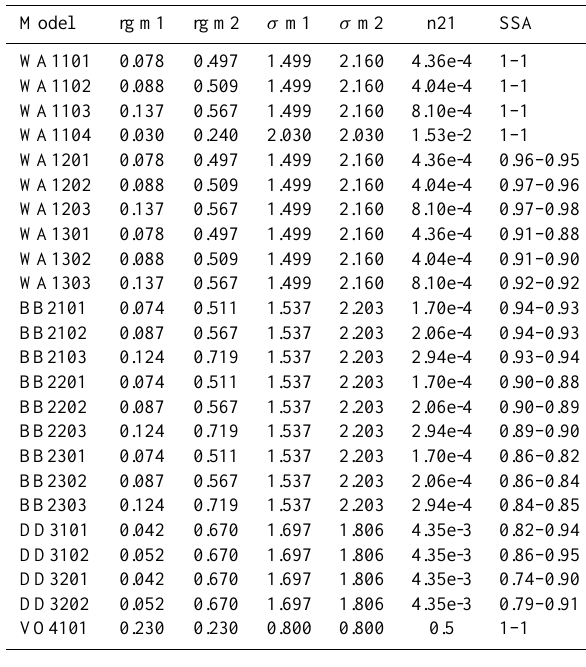
Table 1. The size distribution parameters and the wavelength de- pendent single scattering albedo (SSA) for each aerosol microphys- ical model in LUTs used in this study. The third digit in the model ID number, which is zero in the table, has a range of 1–3 for BB and DD models, and 1 for WA and VO models, is used for different vertical distributions. The mean particle radius, rg [micron] and the standard deviation, σ [micron], are given for both modes, m1 and m2, of bimodal distribution, and n21 is the second mode fraction of the number concentration. The SSA is given for the first and last wavelength band